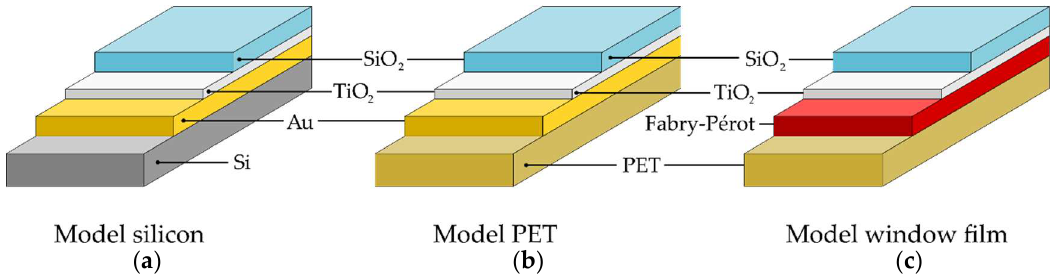
Figure 1. Composition of ( a ) the TiO 2 /Au/silicon model sample; ( b ) the TiO 2 /Au/polyethylene terephtalate (PET) model sample; ( c ) the window film. The model sample was built up on silicon or plain PET, on which a gold layer was deposited. The window film functionality comes forth from the functional metal/metal oxide layer. All samples were provided with a titania buffer layer, on which the protective silica coating was deposited.